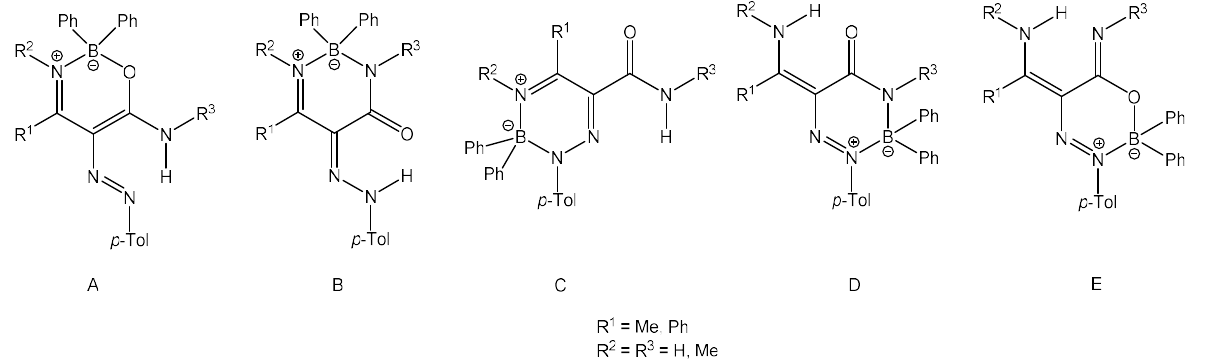
Figure 2. Possible products of the reaction of enaminoamides 1a–h with 4-methylbenzenediazonium tetraphenylborate.